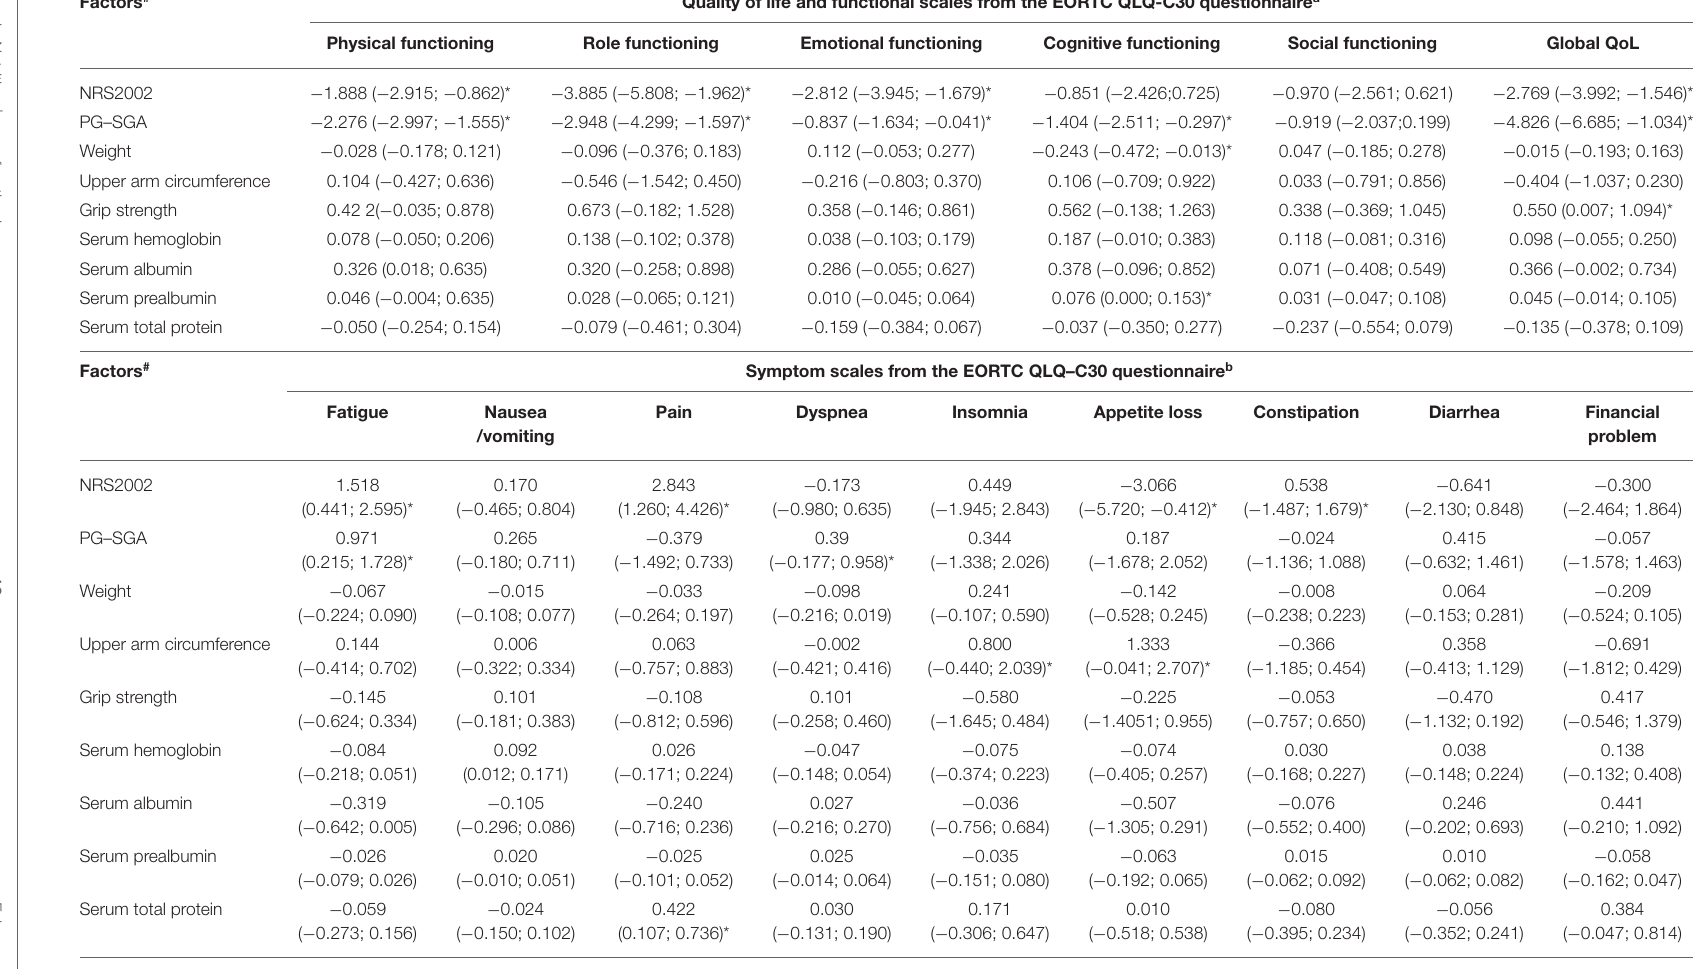
TABLE 4 | Multivariable linear regression model on quality of life, symptom scales, and functional scales from the EORTC QLQ-C30. Factors